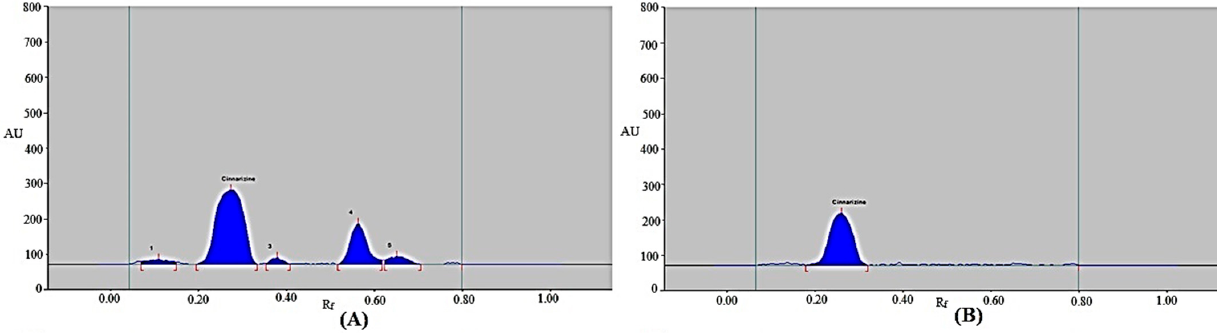
Figure 5. Typical chromatograms of CIN recorded under ( A ) acidic stress test, ( B ) basic stress test, ( C ) oxidative degradation test, and ( D ) thermal stress test of CIN. Table 6. Results of forced degradation investigations of CIN under distinct stress conditions for the present approach (mean ± SD; n = 3). Stress Condition Number of Degradation Products (R f )